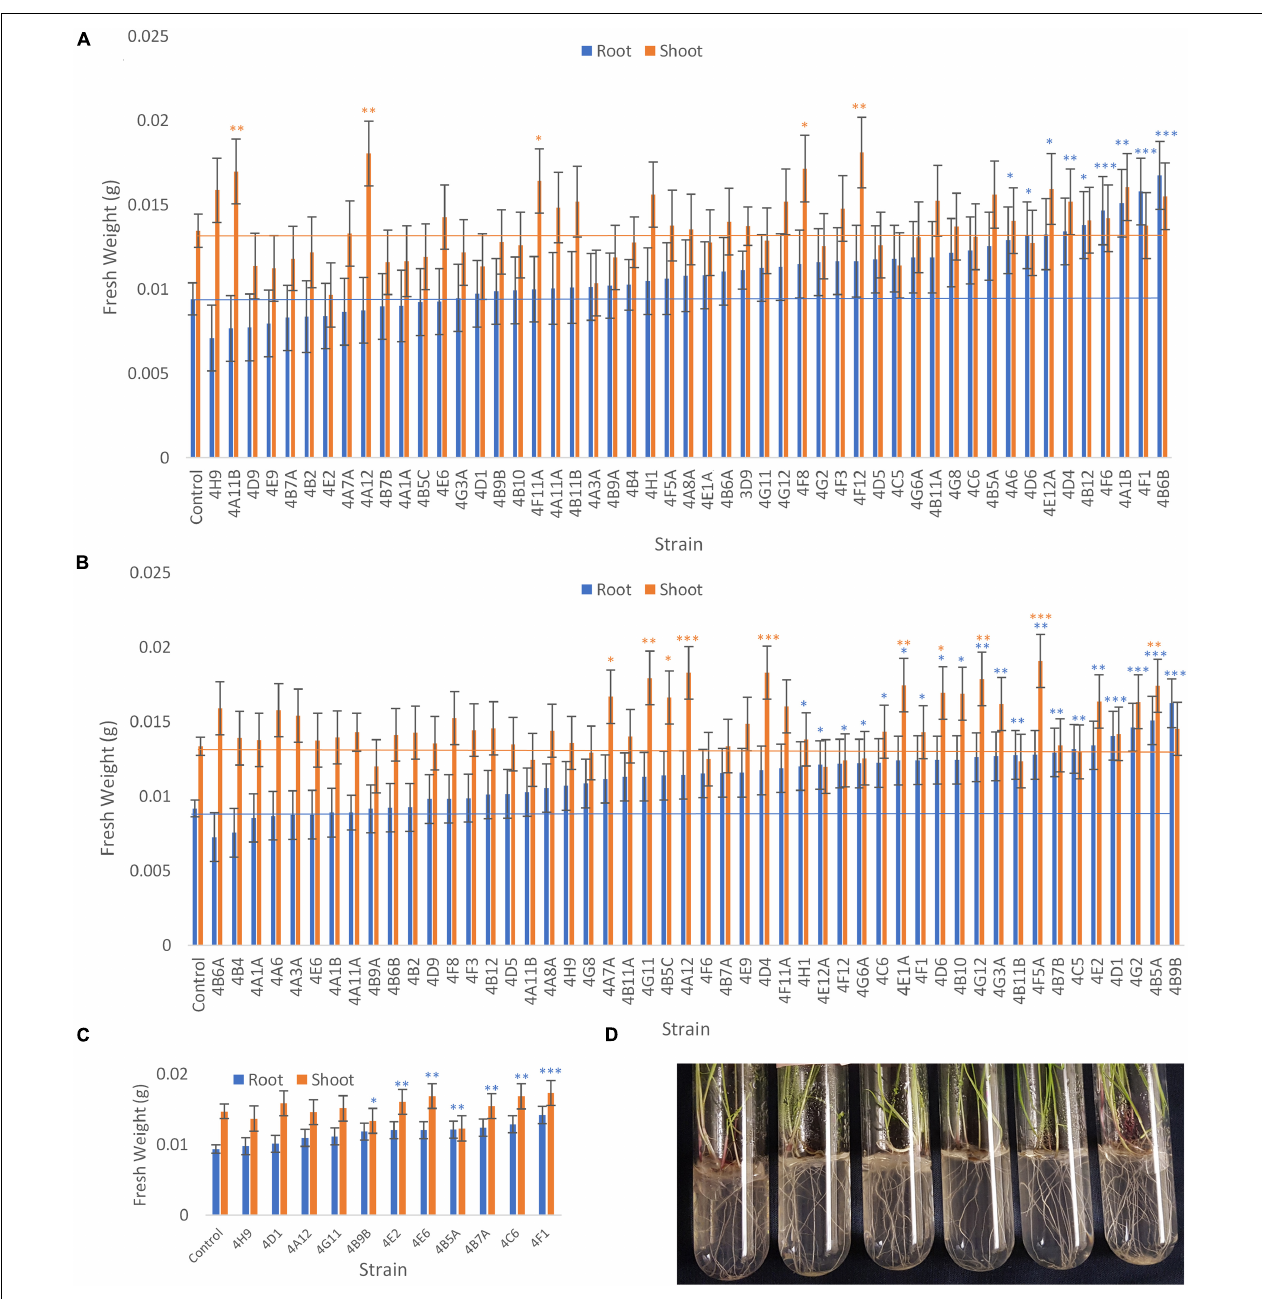
FIGURE 4 | Effect of endophyte seed coating on root and shoot fresh weight of annual ryegrass. Shown are the mean fresh weights of annual ryegrass, seed-coated with endophyte strains, and grown in N-free media for 4 weeks: (A) Trial 1, (B) Trial 2, and a subset in (C) Trial 3. Data is ordered by increasing root biomass (blue bars), and values significantly greater than the uninoculated control are denoted by ∗ P < 0.1, ∗∗ P < 0.05, and ∗∗∗ P < 0.01 as determined by F -tests. Error bars represent the standard error. (D) Images of the assay system: annual ryegrass growing in glass tubes in Phytagel based